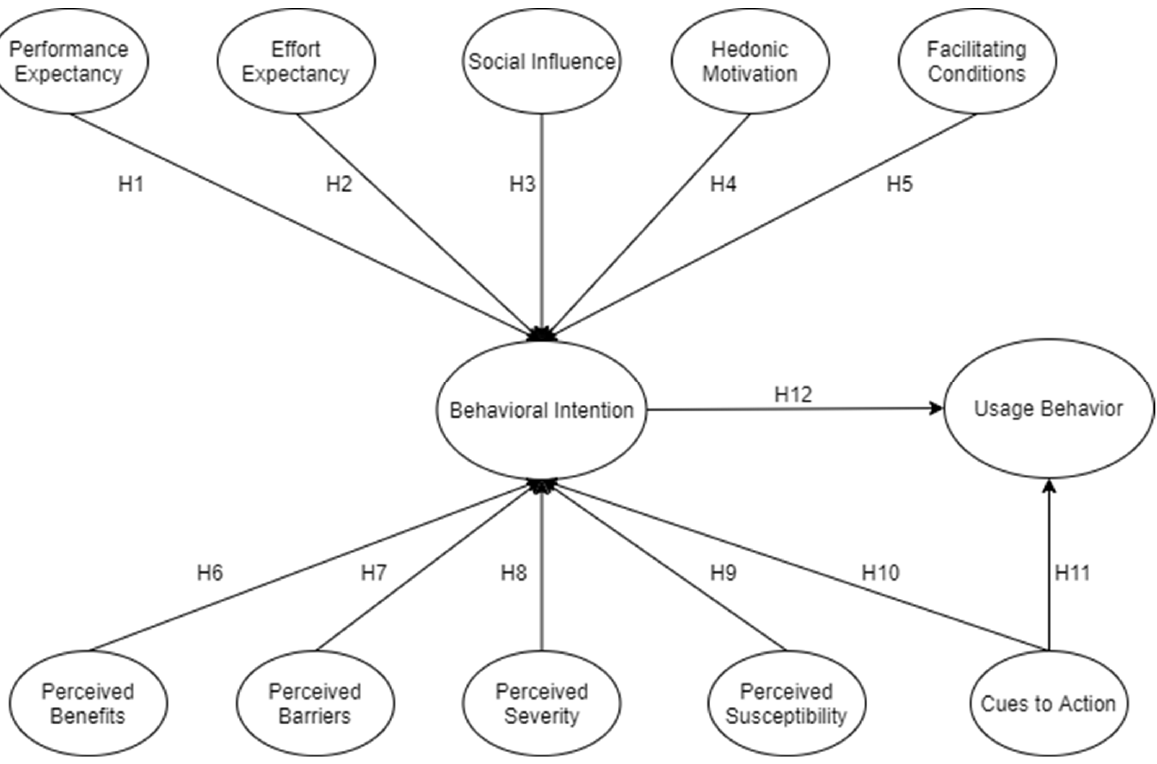
Figure 1. The proposed conceptual framework.